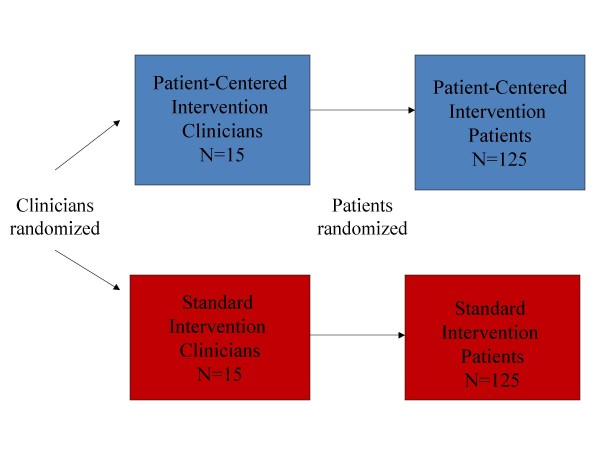
BRIDGE study design.